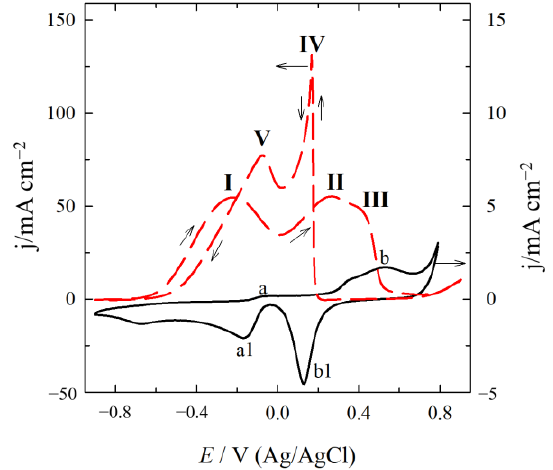
Figure 4. Stabilized CVs of the bare Au electrode recorded in the 0.1 M NaOH solution (solid line) and that containing 0.1 M glucose (dashed line) at 25 °C at an electrode potential scan rate of 50 mV s − 1 .